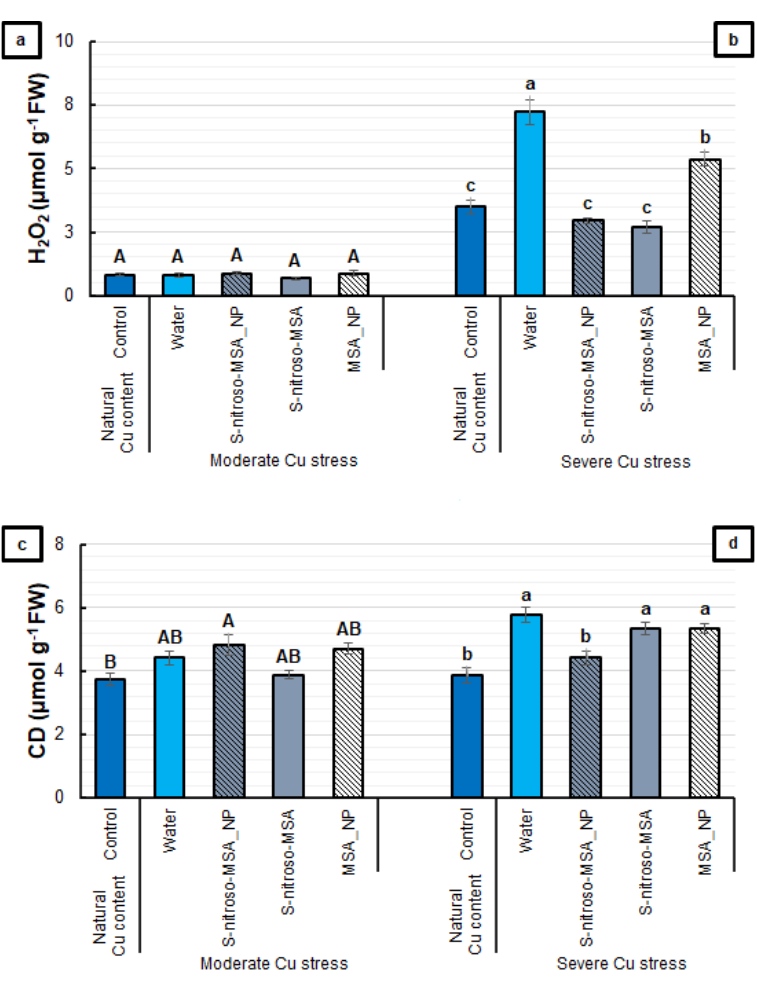
Figure 7. Root H 2 O 2 ( a , b ) and conjugated dienes (CD) ( c , d ) contents of soybean plants cultivated in soil containing different copper (Cu) levels (natural content: 11 mg kg −1 ; moderate Cu stress: 164 mg kg −1 ; severe Cu stress: 244 mg kg −1 ). Control = treatment with distilled water; water = treatment with distilled water after Cu addition; S-nitroso-MSA_NP = treatment with a nanoencapsulated NO donor ( S -nitroso-mercaptosuccinic acid) at 1 mM; S-nitroso-MSA = treatment with a NO donor (S-nitroso-mercaptosuccinic acid) in the free form at 1 mM; MSA_NP = treatment with nanoparticles containing the non-nitrosated MSA at 1 mM. Data are the mean ± standard error ( n = 4). The same uppercase and lowercase letters on the column (referring to experiments 1 and 2, respectively) in- dicate values that do not differ by ANOVA, followed by the Tukey test ( p < 0.05). When evaluating the antioxidant enzyme activity, S-nitroso-MSA tended to show the lowest SOD activity in both experiments (Figure 8a,b). For the POD activity, the treat- ments did not differ from the control under moderate Cu stress (Figure 8c). Severe Cu stress induced nearly doubled the POD activity in the water treatment compared to the